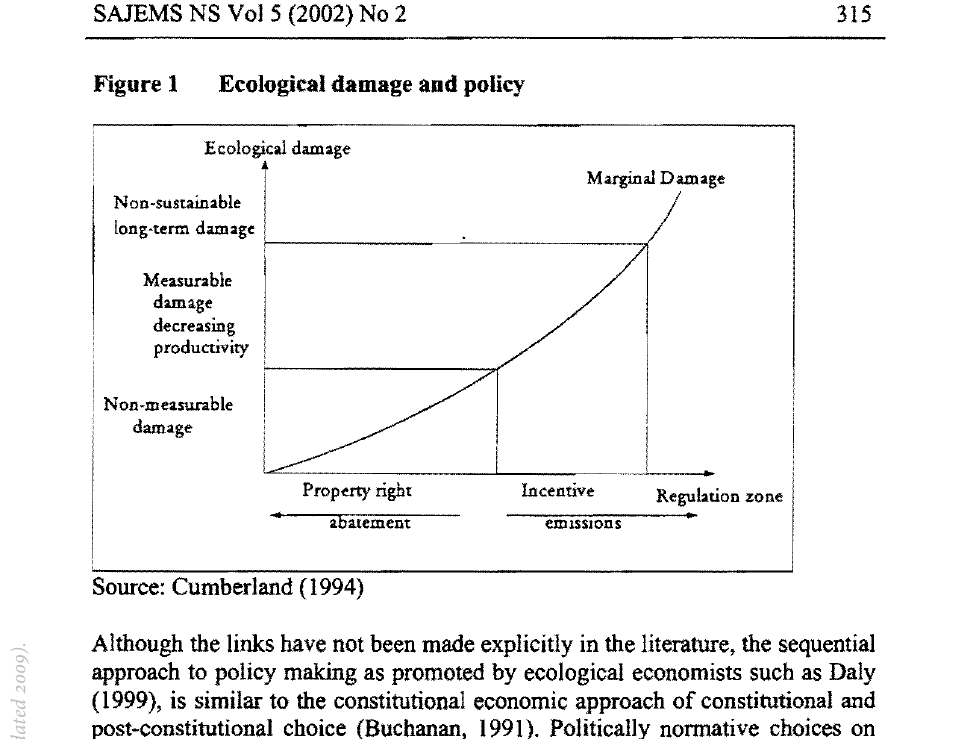
Ecological damage and